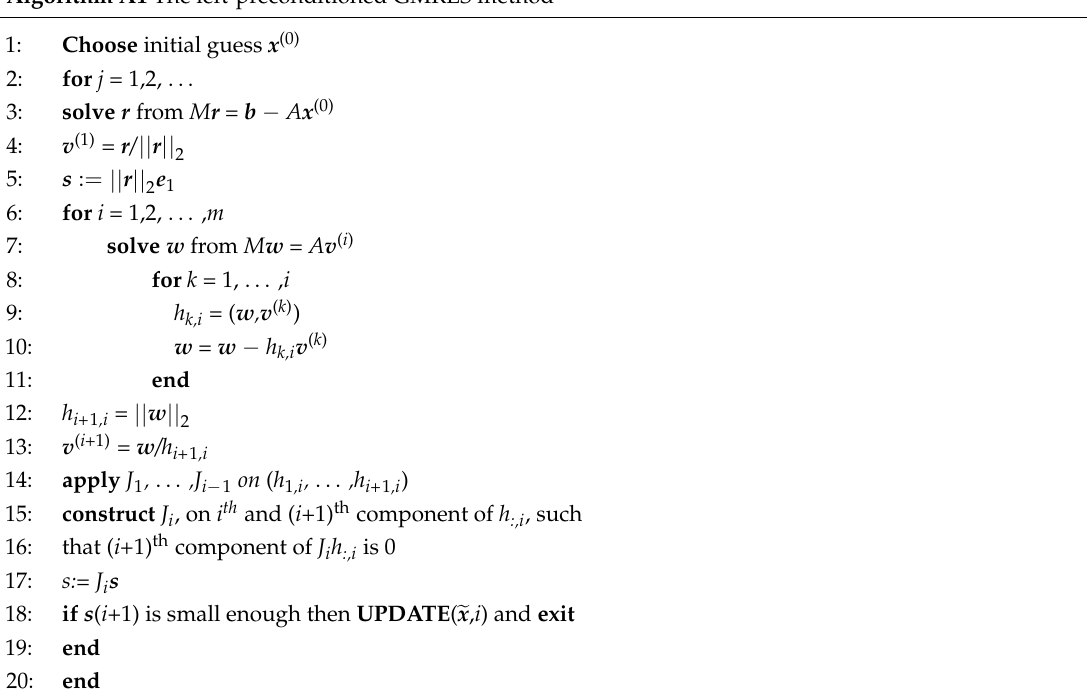
Algorithm A1 The left-preconditioned GMRES